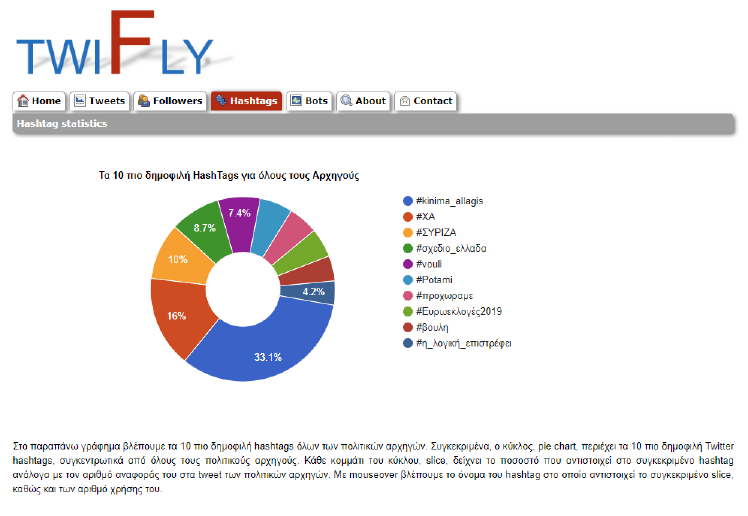
Figure 3. A screenshot of our